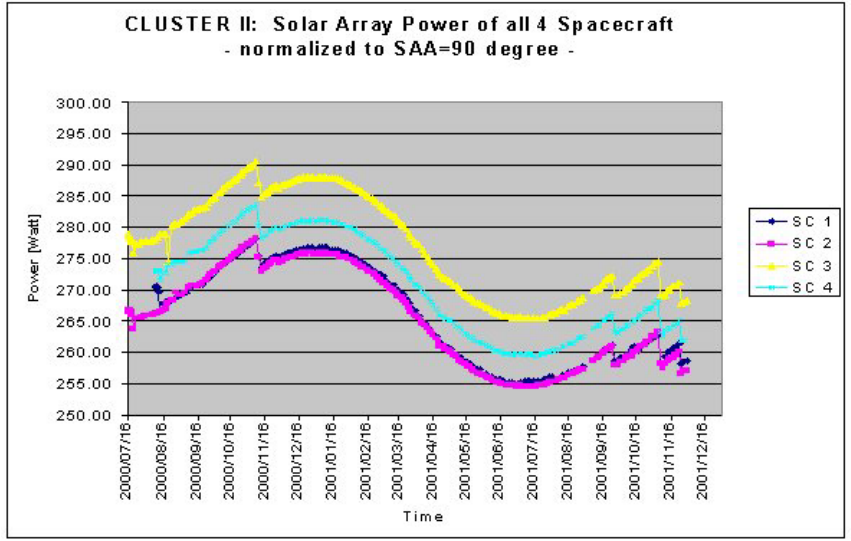
Fig. 2. Solar array power for the 4 Cluster spacecraft. The annual modulation due to the varying Earth-Sun distance was interrupted by abrupt downward steps during a solar proton event in late 2000 and again by 3 events in late 2001. Courtesy ESA (J.